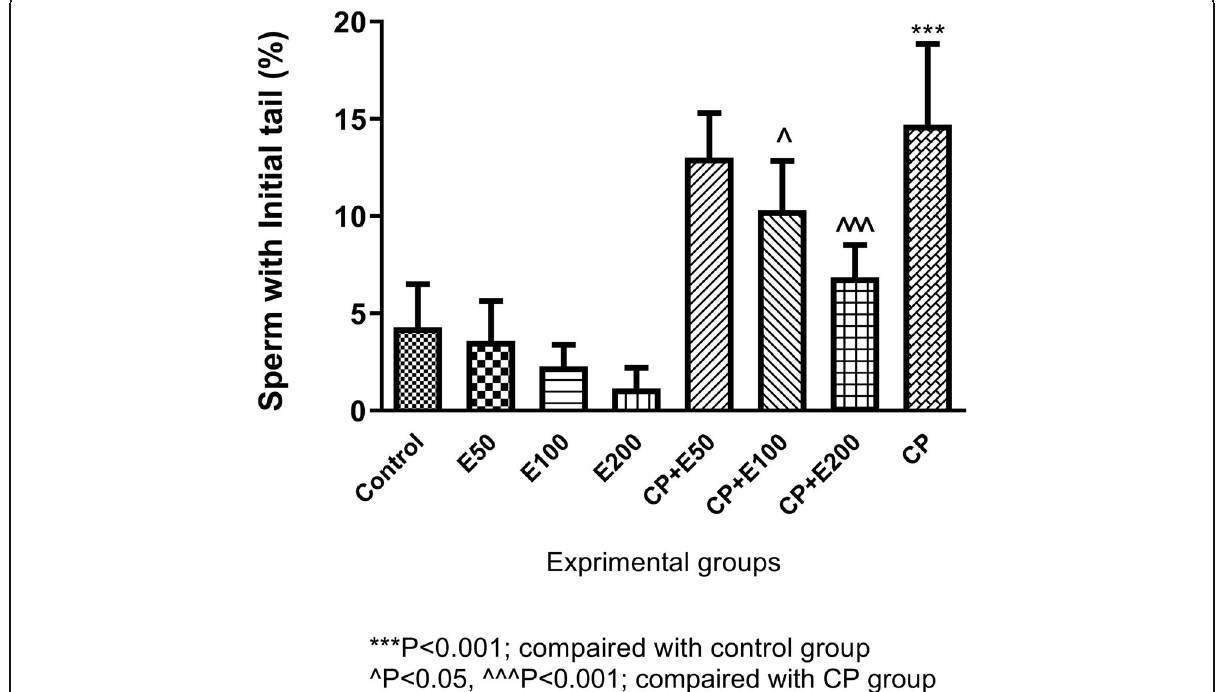
Fig. 7 The effect of Allium atroviolaceum L. extract (E) on the number of the sperm with initial tail in cyclophosphamide (CP)-treated